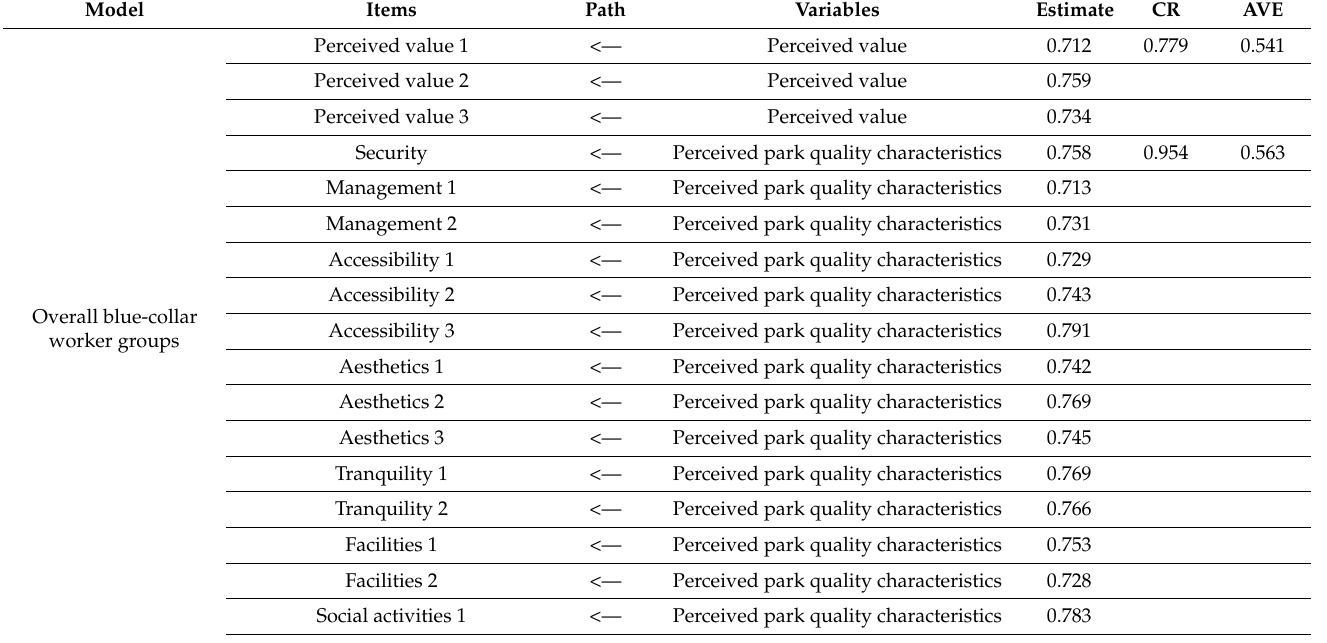
Table A4. Reliability and validity analysis by